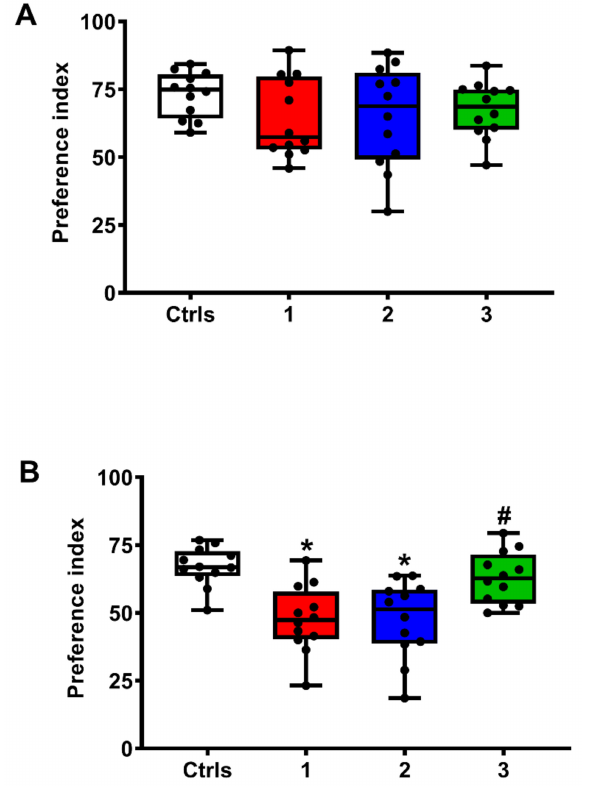
Figure 8. The box plots reporting all data points ( • ), minimum, maximum, median, 25 and 75 percentiles of the Preference Index (PI), as a measure of NOR-STM ( A ) and NOR-LTM ( B ), at 7 days post-injury of rats without and with the s.c. administration of two ILB ® doses (1 and 5 mg/kg b.w.). Ctrls = control sham-operated rats; 1 = sTBI only, sacrificed at 7 days post-injury; 2 = sTBI + 1 mg/kg b.w. ILB ® , sacrificed at 7 days post-injury; 3 = sTBI + 5 mg/kg b.w. ILB ® , sacri- ficed at 7 days post-injury. * Significantly different from controls, q < 0.05. # Significantly different from untreated sTBI rats, q <